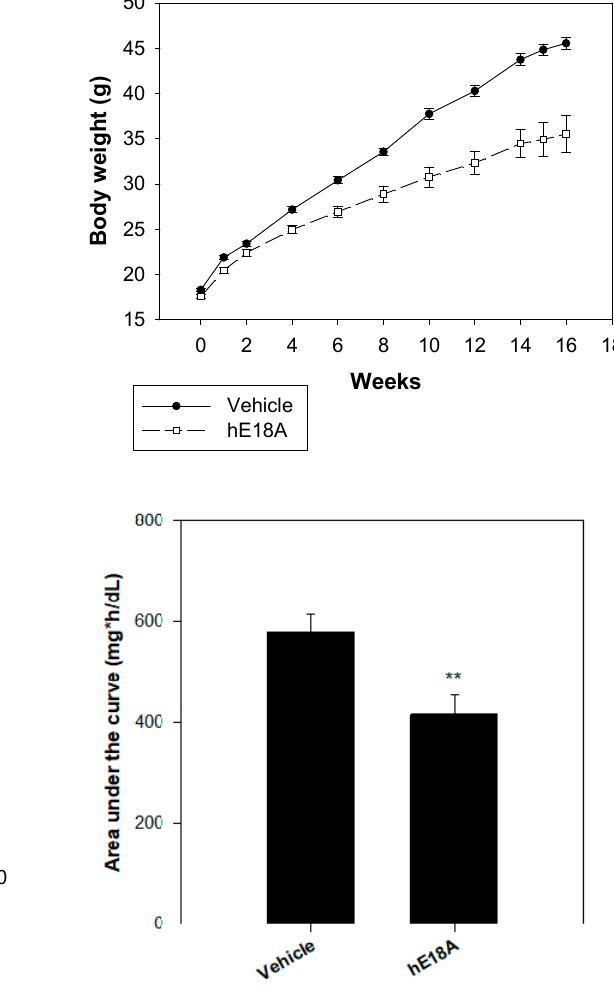
Figure 2. Effect of apoE mimetic peptide Ac-hE18A-NH 2 on insulin resistance. Male C57BL6/J mice were fed a diet containing 60% fat by calories at five weeks of age, and treatment was immediately begun with vehicle or AEM-28 (three times weekly i.v., 200 µg/mouse) and continued through 18 weeks ( N = 15 in each group). ( Top Left ) Plasma insulin levels increased in control mice but not in peptide-administered mice. ( Top Right ) Body weight decreased significantly in peptide-administered mice. ( Bottom Left ) An insulin-tolerance test showed improvement in insulin resistance, as shown by a significant decrease in plasma glucose levels. ( Bottom Right ) Area under the curve from panel C shows a significant decrease in glucose levels. * p < 0.05 vs vehicle; ** p < 0.02 vs